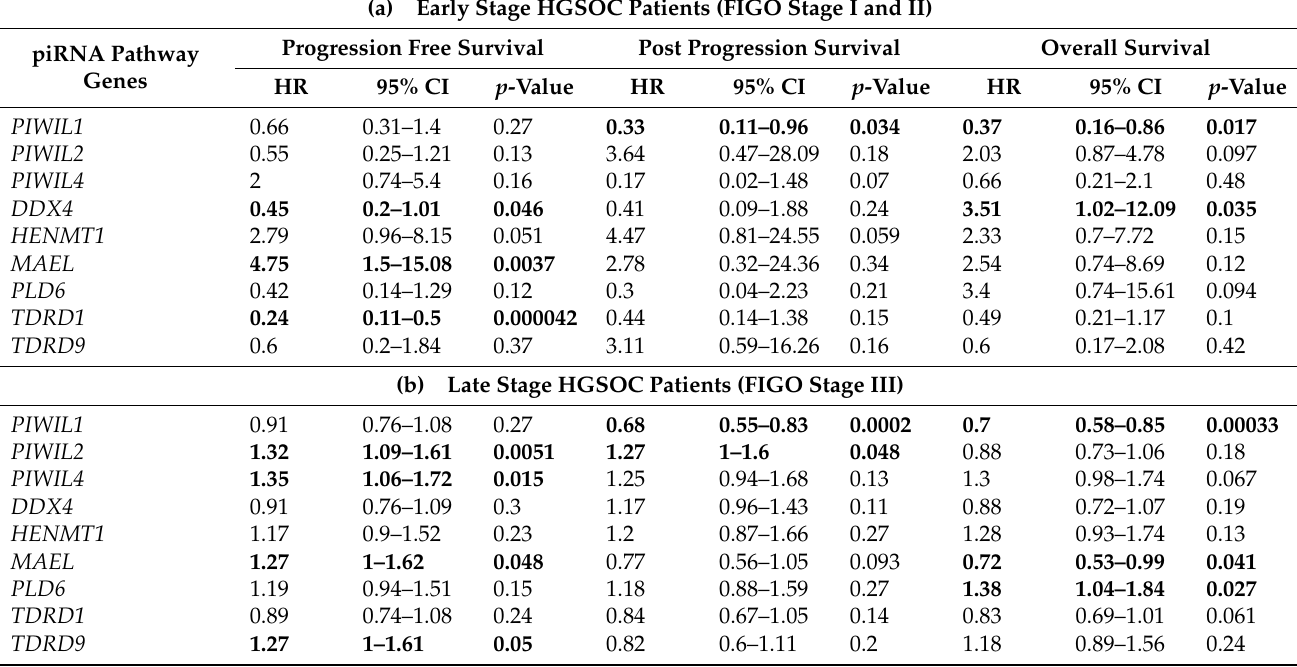
Sample size of early stage HGSOC patients assessed for PFS ( n = 84), PPFS ( n = 32) and OS ( n = 87); late stage HGSOC patients for PFS ( n = 807), PPFS ( n = 573) and OS ( n = 836). HR > 1: low expression confers better outcome; HR < 1: high expression confers better outcome. HR = hazard ratio; 95% CI = 95% confidence interval; p < 0.05 = significant. HR, 95% CI and p -values in bold are